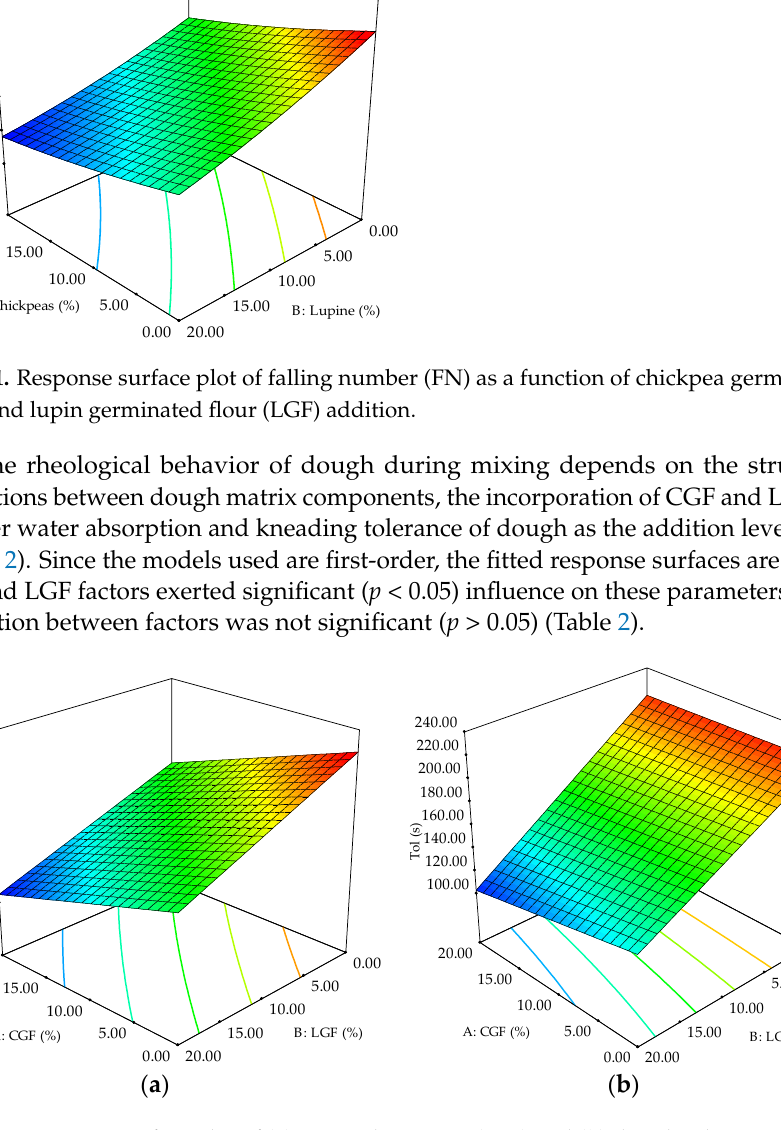
( b ) Figure 3. Response surface plot of ( a ) dough consistency after 250 s (D250) and ( b ) dough con- sistency after 450 s (D450) as a function of chickpea germinated flour (CGF) and lupin germinated flour (LGF) addition. Dough rheological behavior during 3D-deformation could provide valuable infor- mation about handling proprieties. These characteristics are related to the quality and quantity of proteins, the incorporation of other ingredients in wheat flour causing their changes depending on the addition level. The nature surface plots depend on the signs and magnitudes of the coefficients in the model and are given by the mathematical model used. The hyperbolic surface plots presented in Figure 4 for elasticity and extensibility are characteristic for second-order polynomial model. Dough elasticity showed increases proportional to the amounts of CGF and LGF respectively, at levels between 10 and 15% (Figure 4). Both factors exhibited significant effects on dough elasticity ( p < 0.05), while the interaction between them did not have a significant influence (Table 2). On the other hand, dough extensibility registered a decreasing trend as the amounts of CGF and LGF